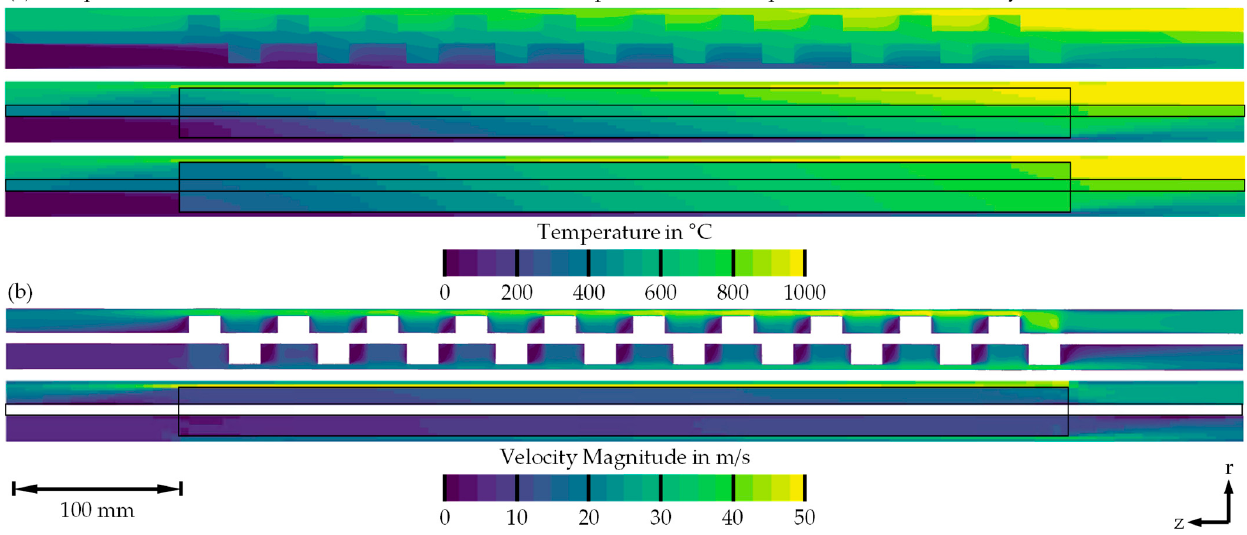
Figure 16. Temperature ( a ) and velocity magnitude ( b ) shown on the axial cross-section of the detailed ( top ) and simplified ( bottom ) geometry for P = 160 kW, λ = 1.15, and T o = 1000 ◦ C.